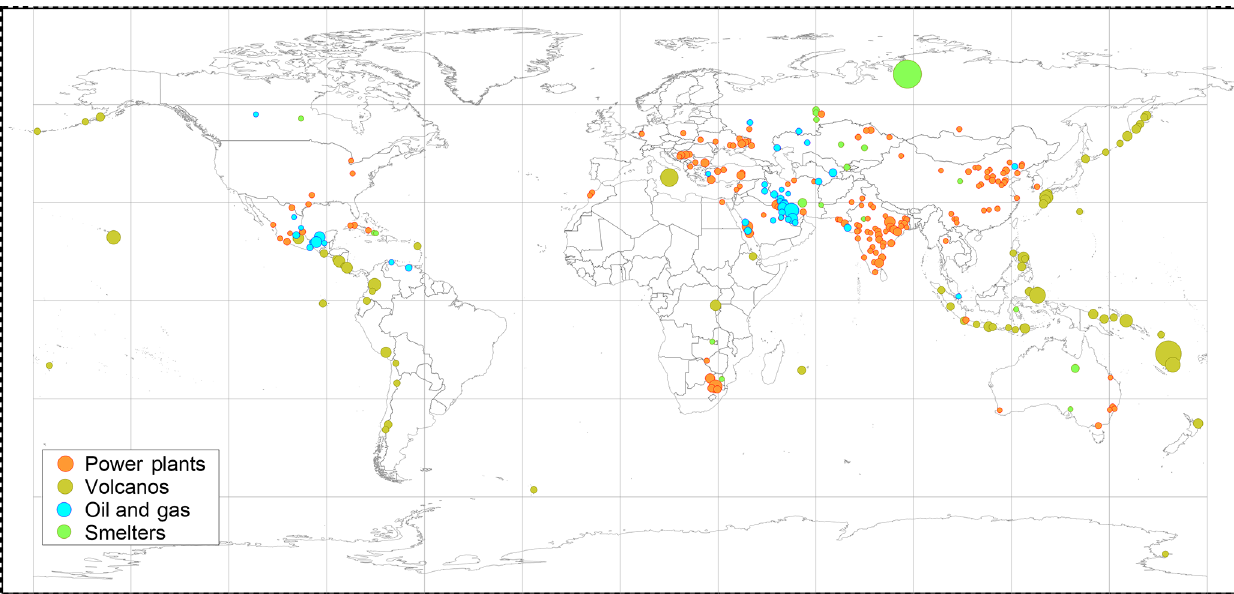
Figure 9. SO 2 emissions sources seen by TROPOMI in 2018. We checked ∼ 500 locations where OMI detected SO 2 emissions between 2005 and 2014 (Fioletov et al., 2016). Note that some of them are not active now or have had their emissions significantly reduced. TROPOMI can “see” 278 sites, including 150 power plants, 19 smelters, 41 oil-and-gas-industry-related sources, and 68 volcanos, with annual emissions from 10 to 2000kt. The size of the symbols is proportional to the annual emission